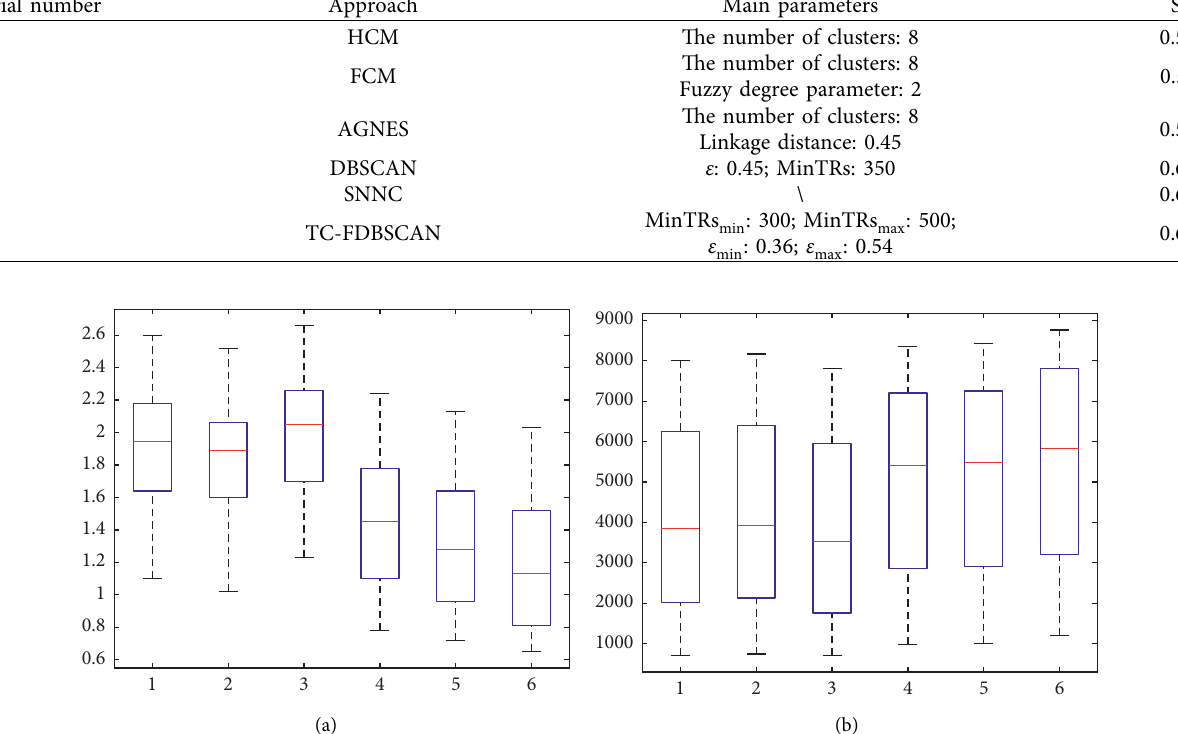
Figure 7: Boxplot diagram of the clustering evaluation for case data. (a) DB index. (b) CH